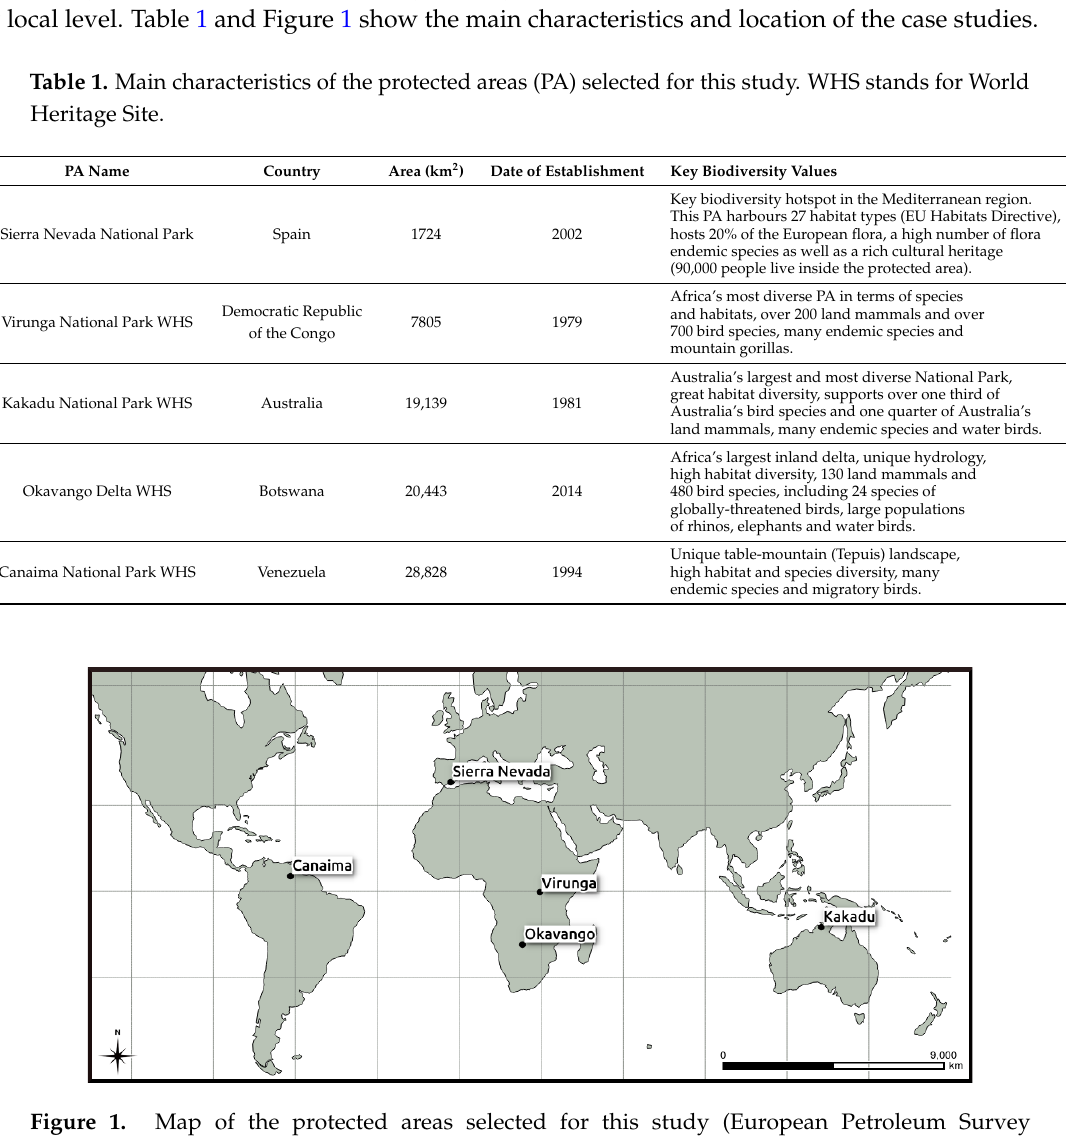
Figure 1. Map of the protected areas selected for this study (European Petroleum Survey